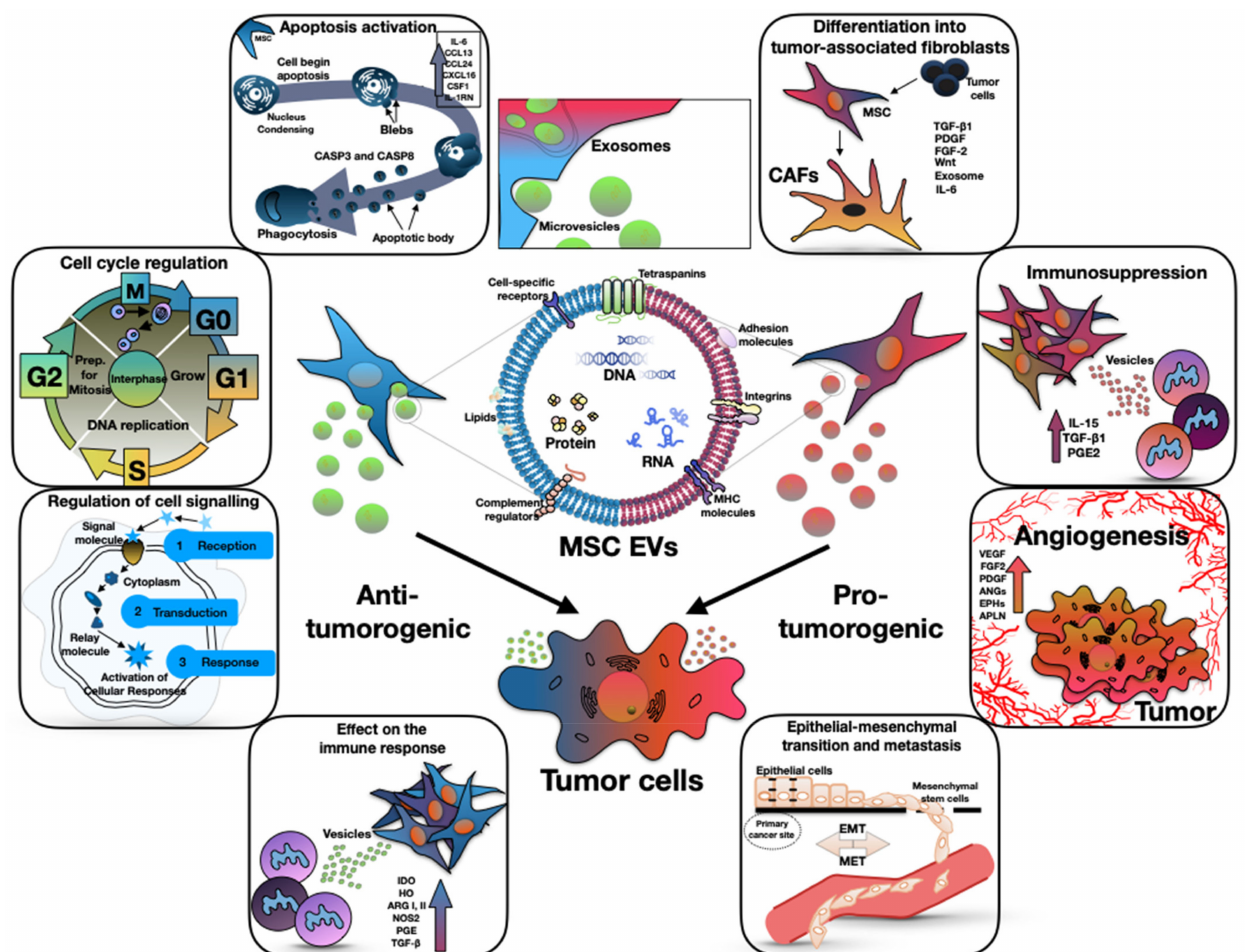
Figure 1. The dual (anti-tumorigenic and pro-tumorigenic) effect of mesenchymal stem cell derived extracellular vesicles on tumor progression. The central part of the figure shows the structure of the EVs. The left side of the figure shows the antitumor effect of EVs through the apoptosis activation, cell cycle regulation, effect on the immune response, and regulation of cell signaling. The right